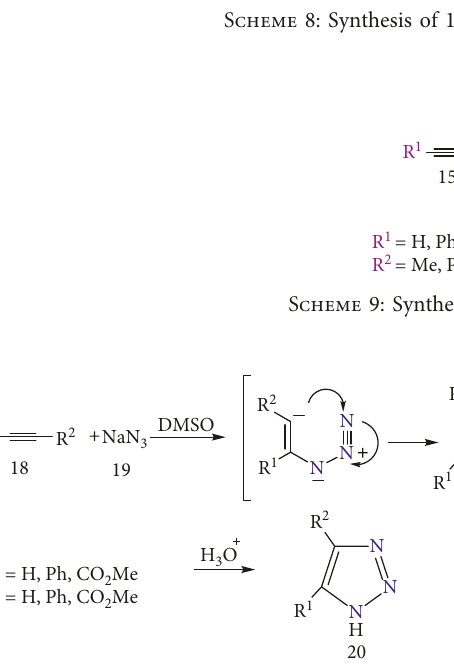
Scheme 10: Synthesis of 1,2,3-triazoles from Azide Ion.